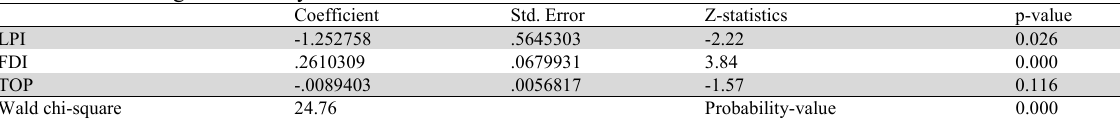
The results of the regression analysis